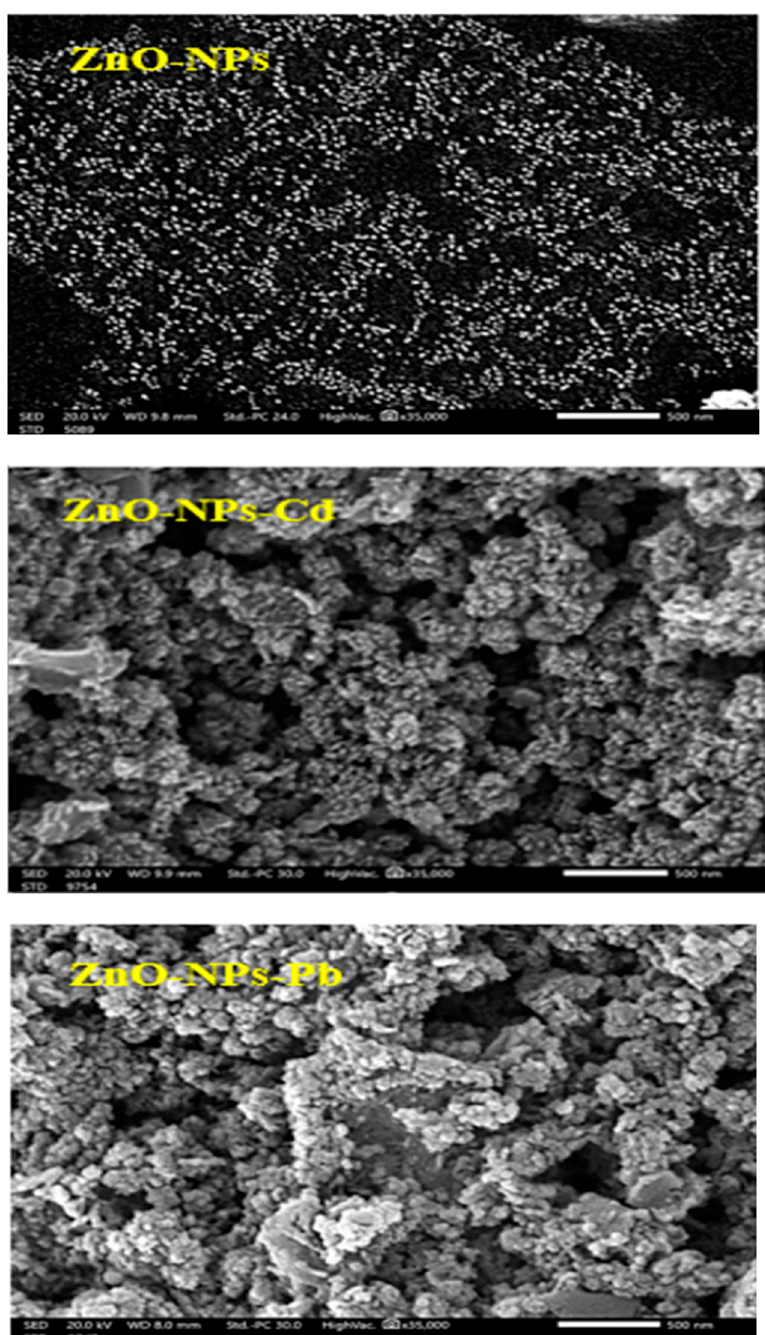
Figure 5. SEM morphology of ZnO-NPs before adsorption and after the Cd 2+ and Pb 2+ ions’ adsorp- tion.